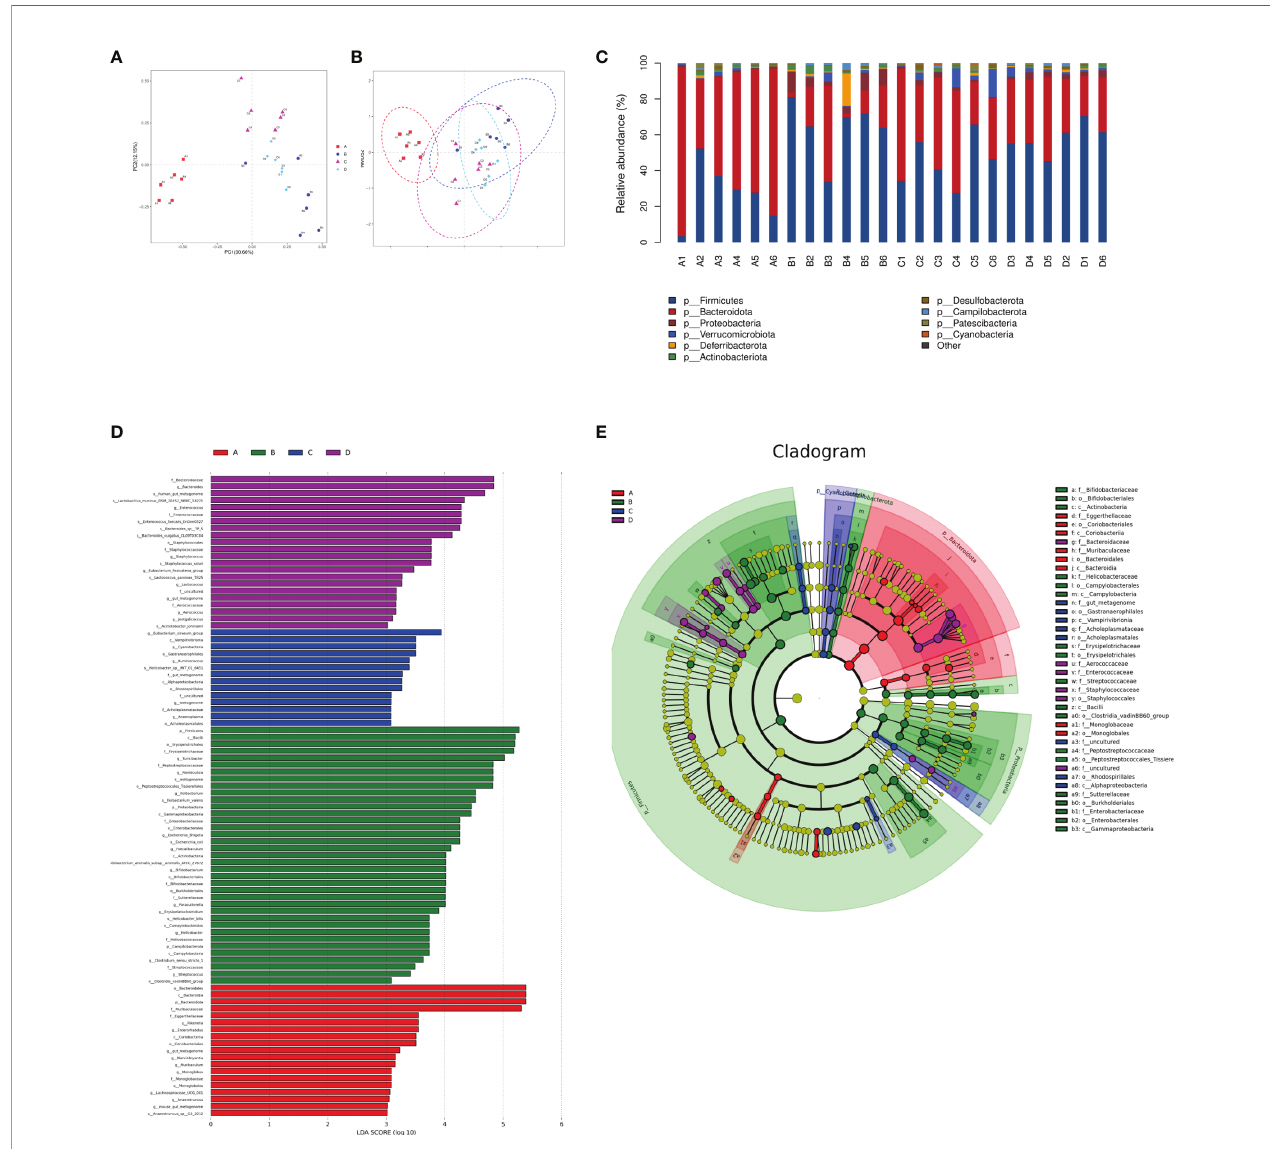
FIGURE 7 | Effect of lactic acid and Saccharomyces cerevisiae on the species composition of the gut microbiota. (A) Principal component analysis (PCA). (B) Non- metric multidimensional scaling (NMDS) analysis. (C) Relative abundance at the phylum level. (D) Differentially enriched intestinal microbiota in all groups at the genus level by linear discriminant analysis (LDA). An LDA score higher than 3 represents a higher abundance in the group than that in other groups. (E) Cladogram based on linear discriminant analysis effect size (LEfSe) analysis. (A) Water+PBS; (B) DSS+PBS; (C) DSS+LAC; (D) DSS+SyBE ( n =